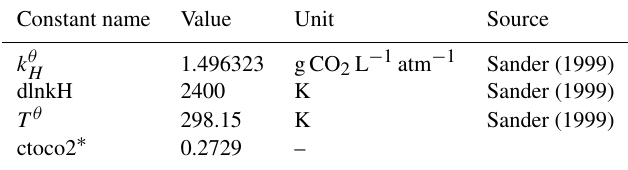
Table 2. List of physical